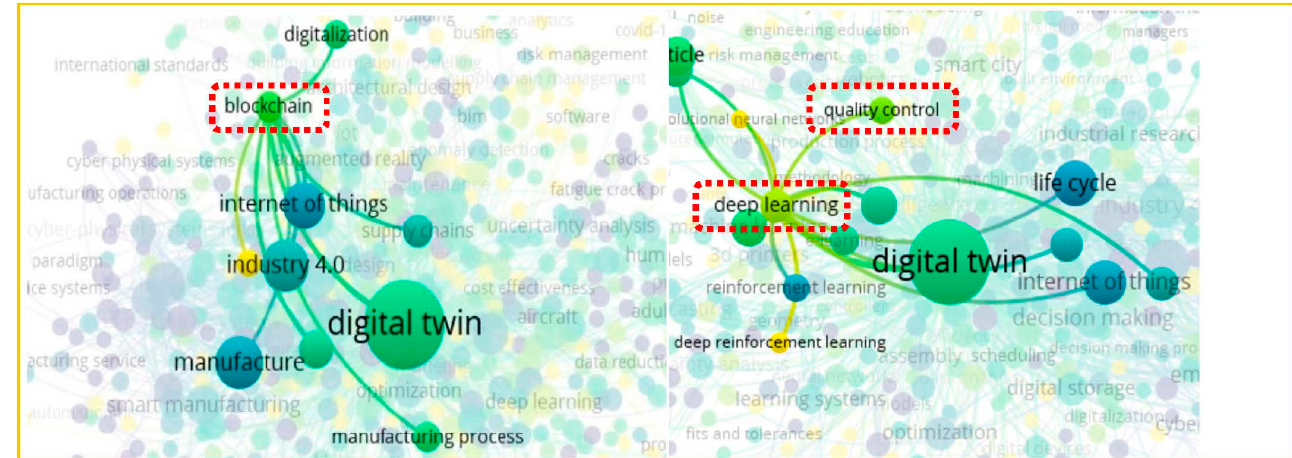
Figure 4. Blockchain, robotics, and deep learning are emerging themes in the DT literature to improve its efficiency.